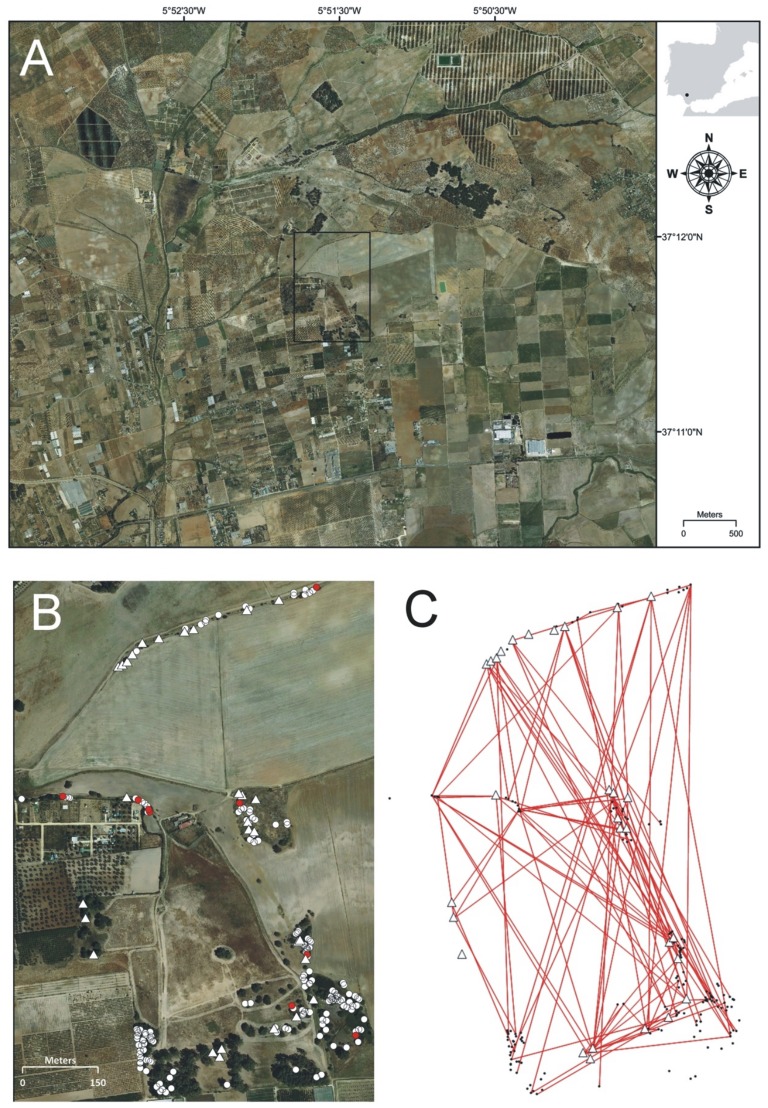
Aerial photography of the study site (black square) embedded in a highly anthropogenic area (A).Close up of the study site showing the 164 reproductive Pistacia lentiscus males (white circles) and the 29 mother plants (white triangles) sampled for mating and paternity analyses (B). Network of effective pollination events detected between males (dots) and females (triangles) in the paternity analysis (C). Red dots in panel B mark the position of males siring at least four seeds (see text for details).